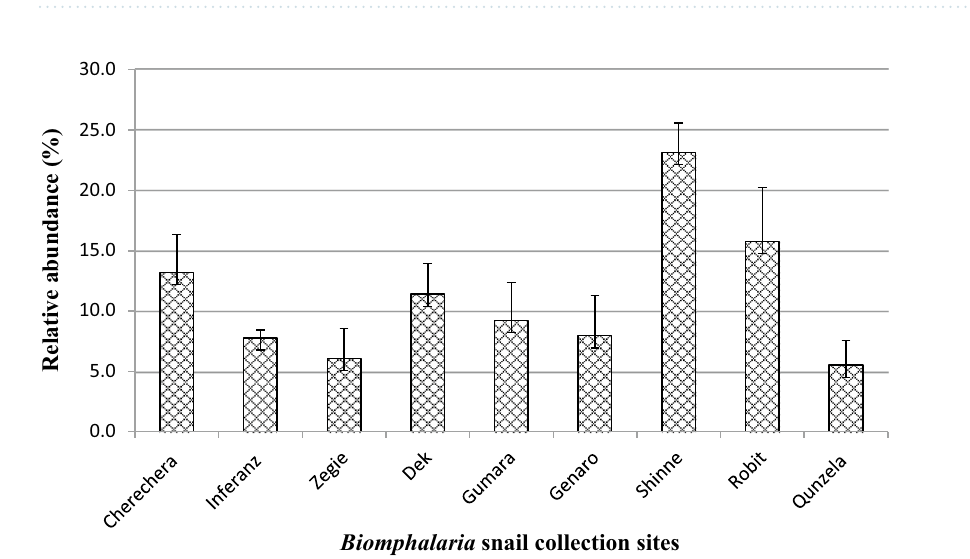
Table 2. Diversity and abundance of freshwater snails of Lake Tana and its tributary rivers, 2021/22.